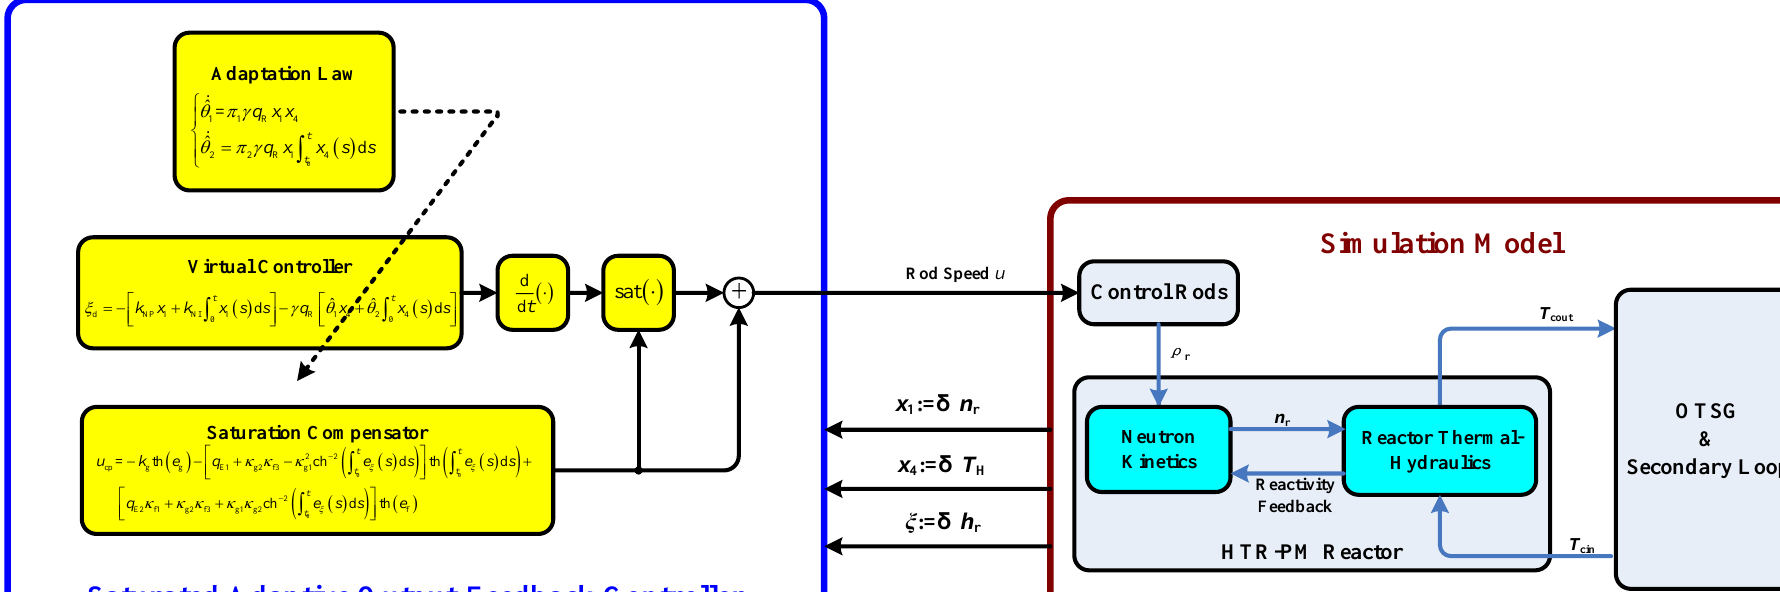
Figure 3. Schematic view of the closed-loop